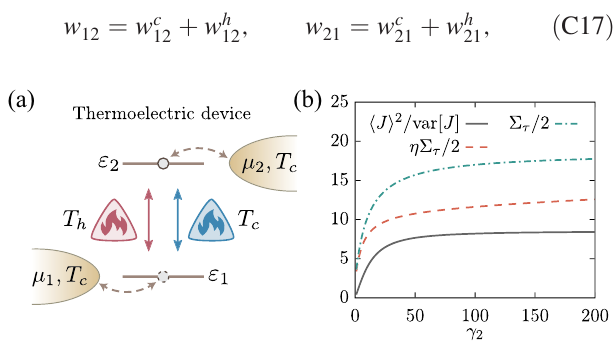
FIG. 7. Numerical illustration of the thermodynamic uncer- tainty relations. (a) Schematic of the thermoelectric engine that transports electrons from the left to the right lead through the two- level quantum dot and (b) numerical verification. The current precision h J i 2 = var ½ J (cid:2) , new bound η Σ τ = 2 , and conventional bound Σ 2 are depicted by the solid, dashed, and dash-dotted lines, τ = respectively. γ 2 is varied, whereas other parameters are fixed as β 10 , β 0 . 1 , γ 10 , γ γ 1 , ε 0 , ε 1 , 1 ¼ 1 ¼ 2 ¼ c ¼ h ¼ c ¼ h ¼ μ 0 . 4 , μ 0 . 6 , and τ ¼ 1 1 ¼ 2 ¼